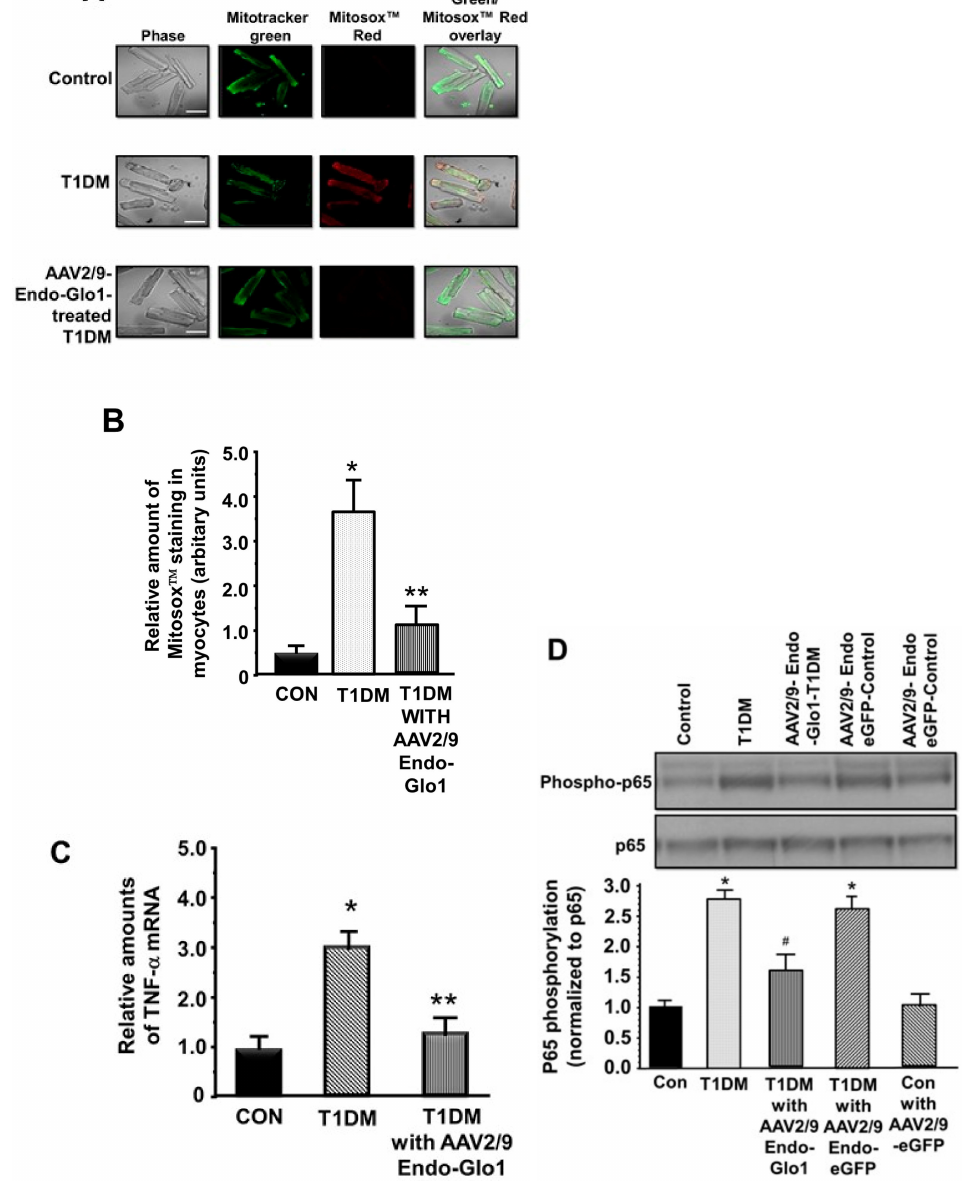
Figure 8. ROS and inflammation in ventricular myocytes. ( A ) shows representative Mitotracker Green (mitochondria) and MitoSox ™ (ROS) fluorescence images in freshly isolated myocytes from the control, T1DM, and AAV2 / 9-Endo-Glo1-treated T1DM rat hearts. Graph below ( B ) is the mean ± S.E.M from > 30 myocytes obtained from n = 5 animals. White bar = 50 µ m. ( C ) shows TNF- α mRNA levels in left ventricular tissues from the control, T1DM, and AAV2 / 9-Endo-Glo1-treated DM normalized to β -actin. Values are mean ± S.E.M from n = 5 rats per group. ( D ) shows a representative autoradiogram for phosphorylated and non-phosphorylated p65 in left ventricular lysates from the control, AAV2 / 9-Endo-eGFP-treated control, T1DM, AAV2 / 9-Endo-eGFP-treated T1DM, and AAV2 / 9-Endo-Glo1-treated DM rats. Values shown in graph below are mean ± S.E.M from n = 3 rats per group. * denote significantly di ff erent from the control ( p < 0.05), # denote significantly di ff erent from T1DM ( p <